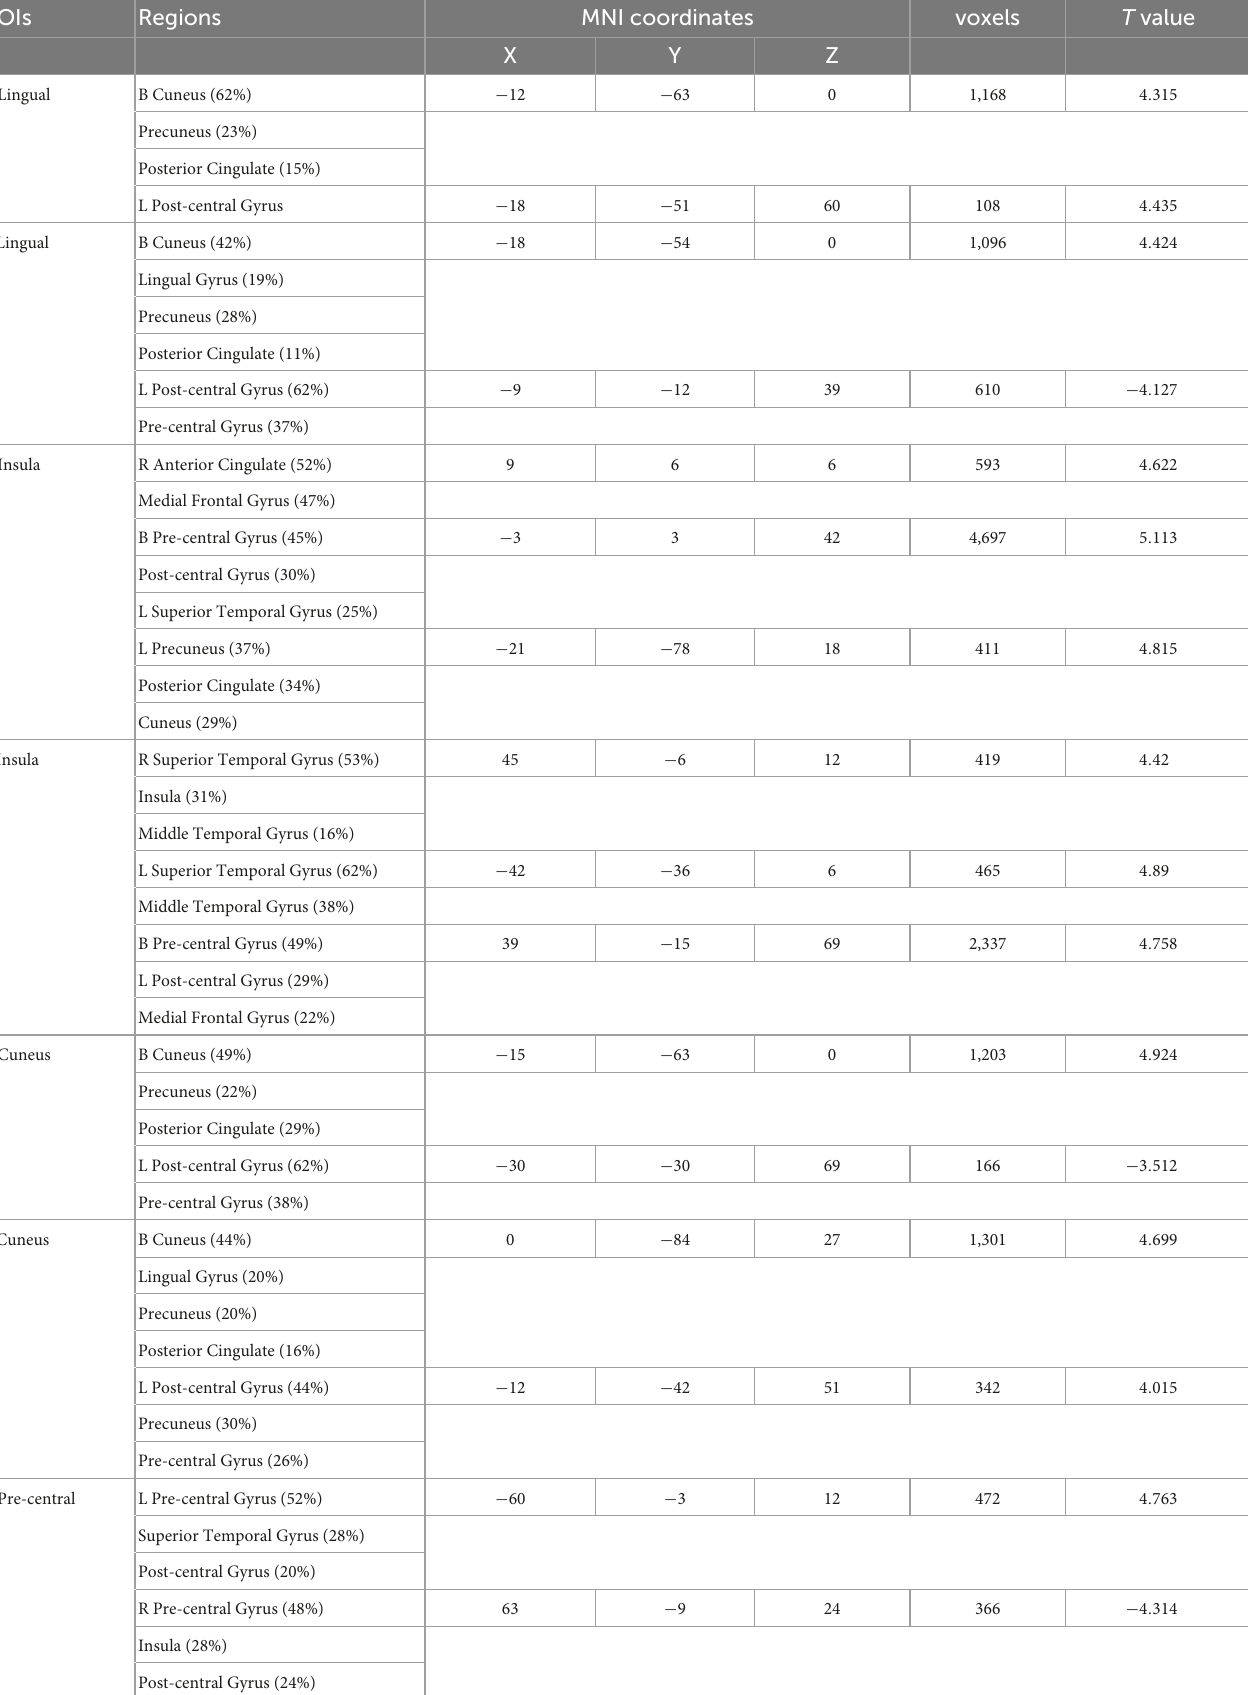
TABLE 3 Group differences in functional connectivity of regions of interest (ROIs) between primary angle-closure glaucoma (PACG) and healthy control (HC). ROIs Regions MNI coordinates voxels T